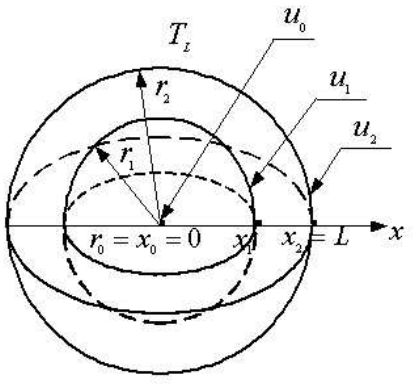
Figure 3. The calculated temperatures u 0 and u 1 in the points x = 0 and x = x 1 in the case of spherical